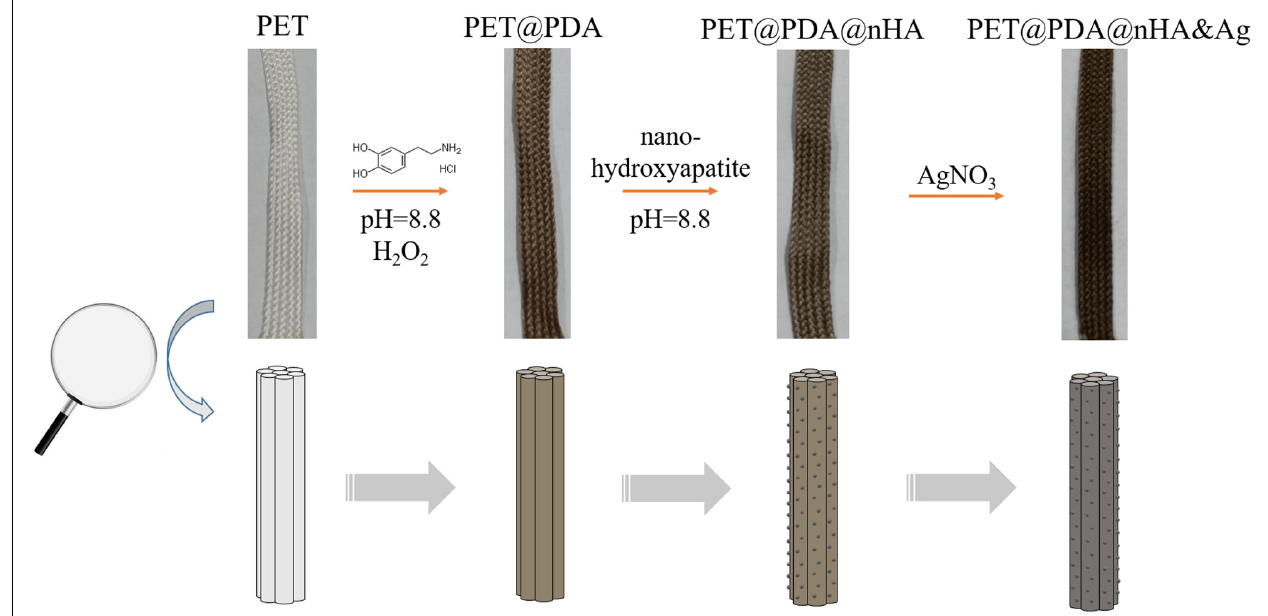
FIGURE 1 | The schematic diagram of the PET ligament modification process. Up line is the photo images of ligaments, and down line is morphology change diagram of ligament